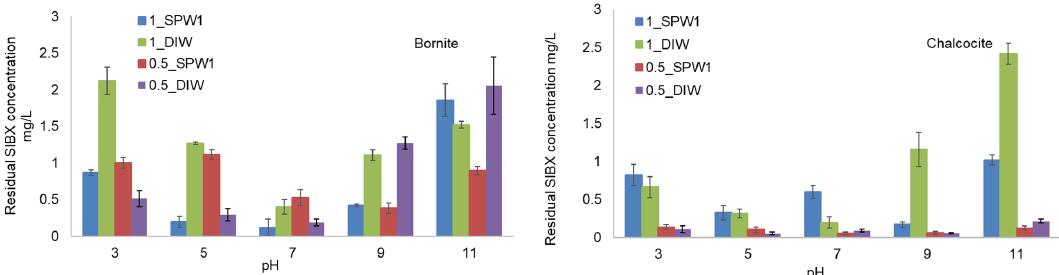
Figure 4. Collector adsorption for bornite and chalcocite in DIW and SPW1 at different pH levels.